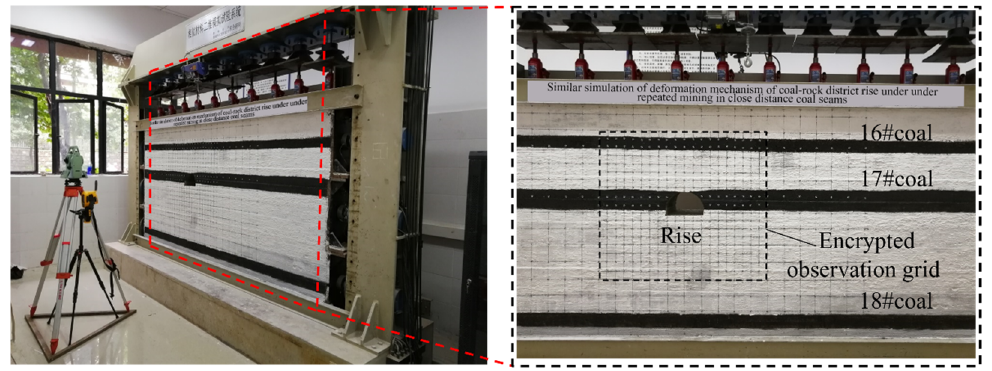
Figure 8. Final drawing of test model.